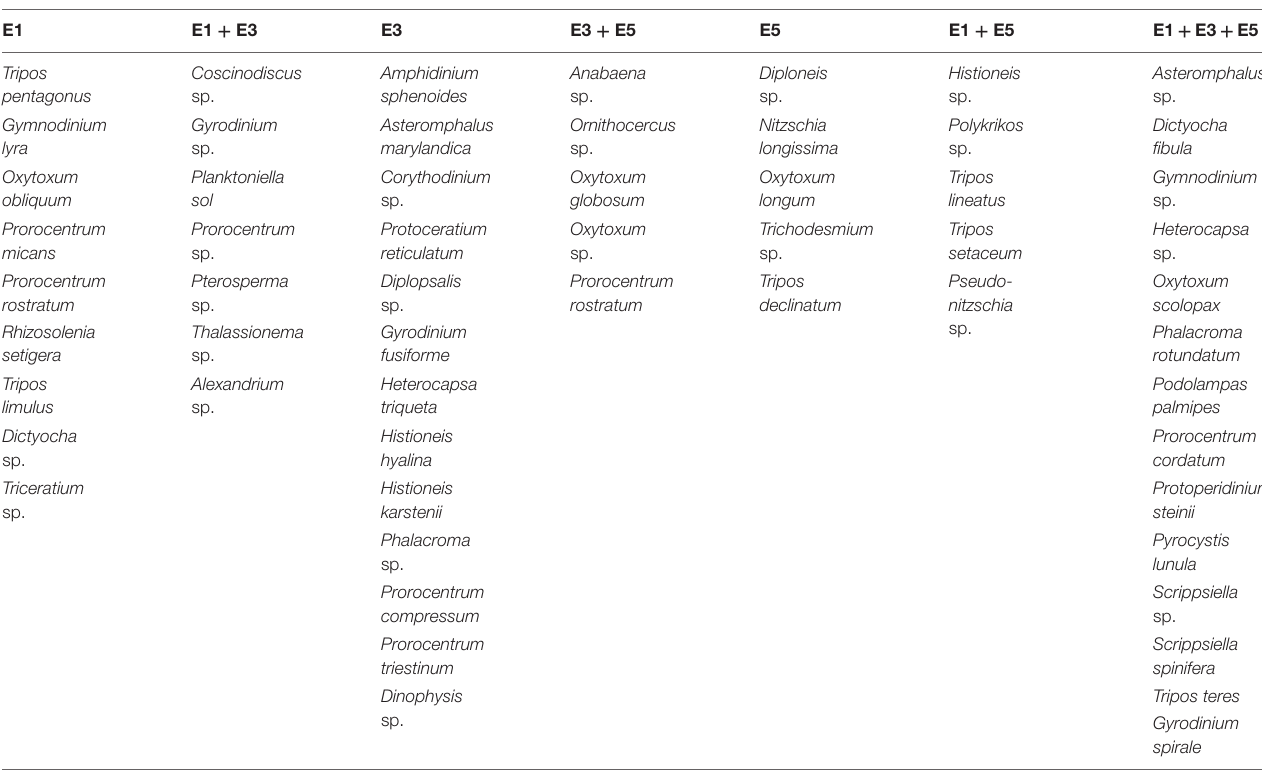
TABLE 3 | Species found specifically in the eddies E1, E3 and E5; or E1 + E3; E3 + E5; E1 + E5; E1 + E3 + E5.